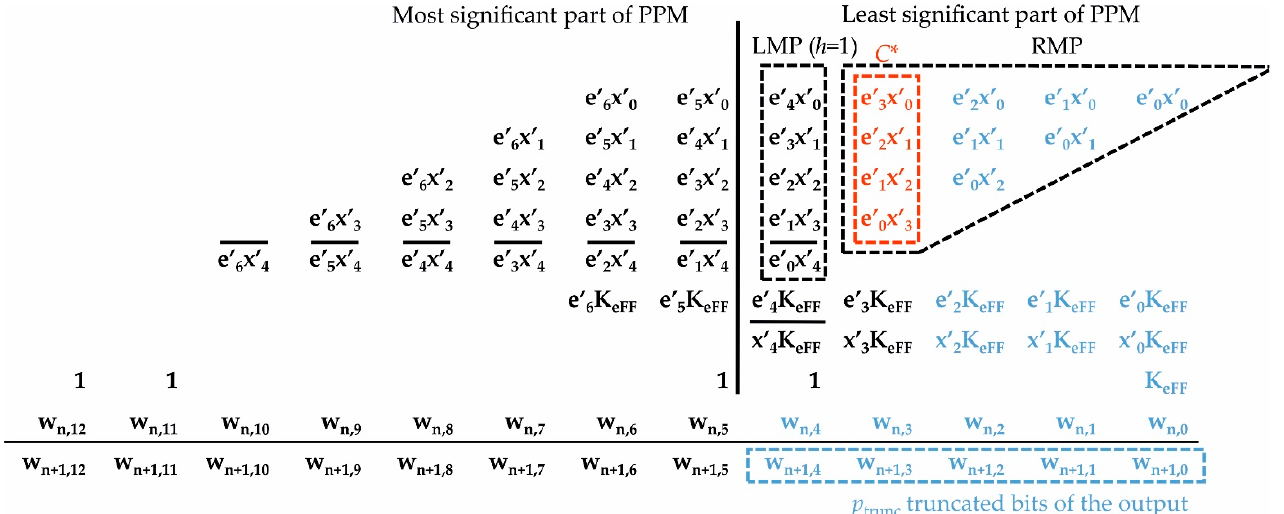
Figure 6. MAC block with the fixed-width technique applied to the product e’( n − 1) ∙ x ’( n − k − 1) and the truncation on e ’( n − 1) ∙ K eFF 2 0 , x ’( n − k − 1) ∙ K eFF 2 0 and K eFF 2 0 .